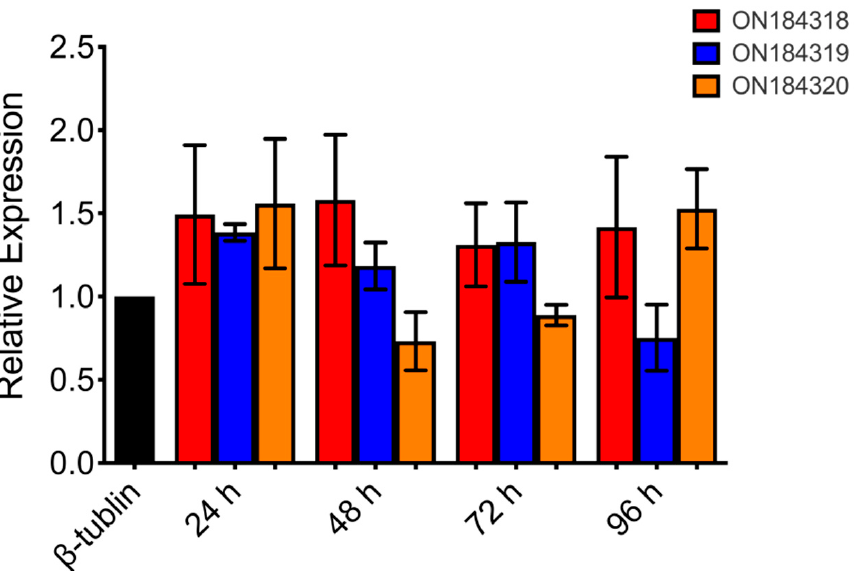
Figure 2. Relative transcription levels of three genes quantified using RT-qPCR at different interaction times. β -Tubulin was used as the standard for the statistical analysis of the transcription level of three genes in different co-culture times relative to those in the wild-type strain under a given condition. Error bars indicate the standard deviations.